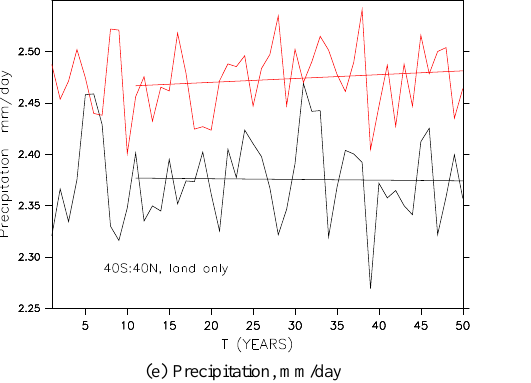
Fig. 5. Trends in the pre-industrial (black) and Mid-Holocene (red) experiments: (a) surface air temperature, (b) sea surface temperature, (c) sum of the sensible and latent surface heat flux, (d) net TOA flux (top of atmosphere net short- and longwave) and (e) precipitation. Figures (a) , (b) , (c) and (e) are 40 ◦ S:40 ◦ N zonal and annual averages, (e) is over land only, and (d) shows a global annual average. The trend over the last 40 years has been drawn in all figures for both